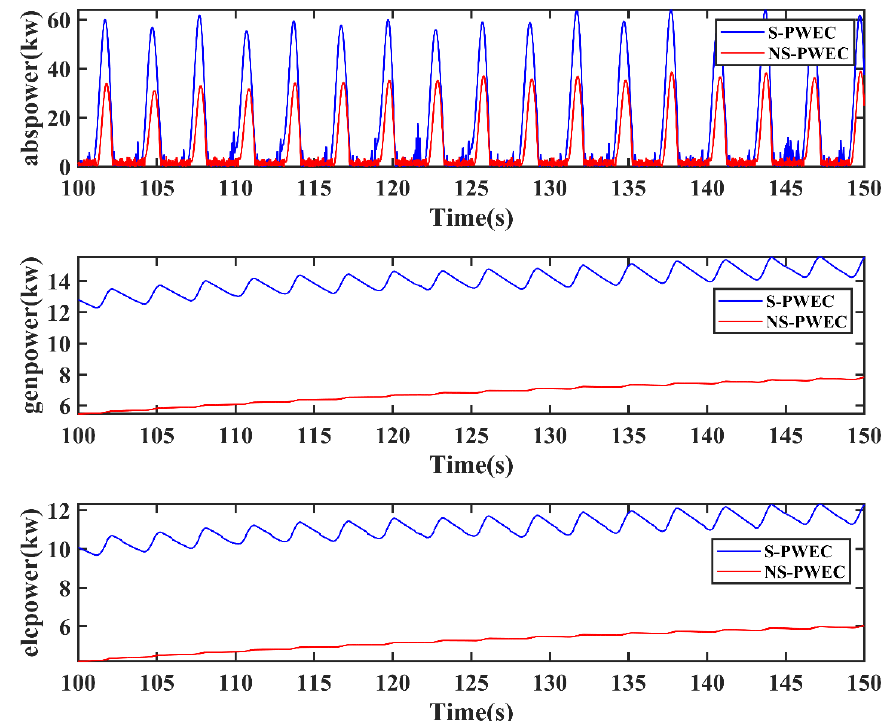
Figure 7. Power output of S-PWEC and NS-PWEC.